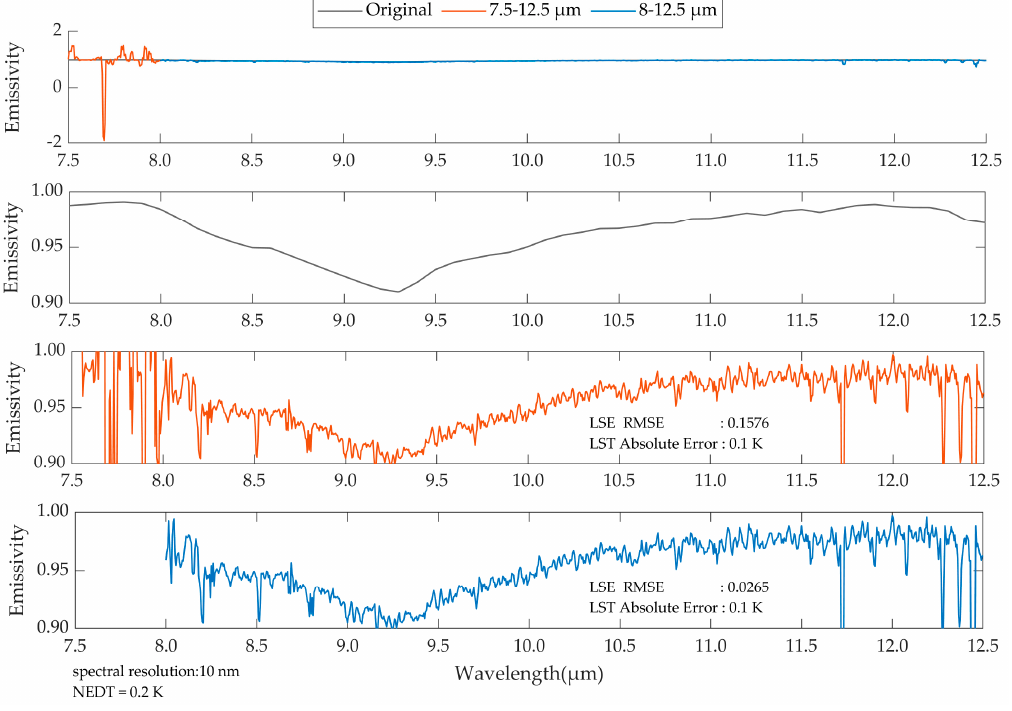
Figure 3. A case of outliers occurring in the retrieved LSE spectrum.